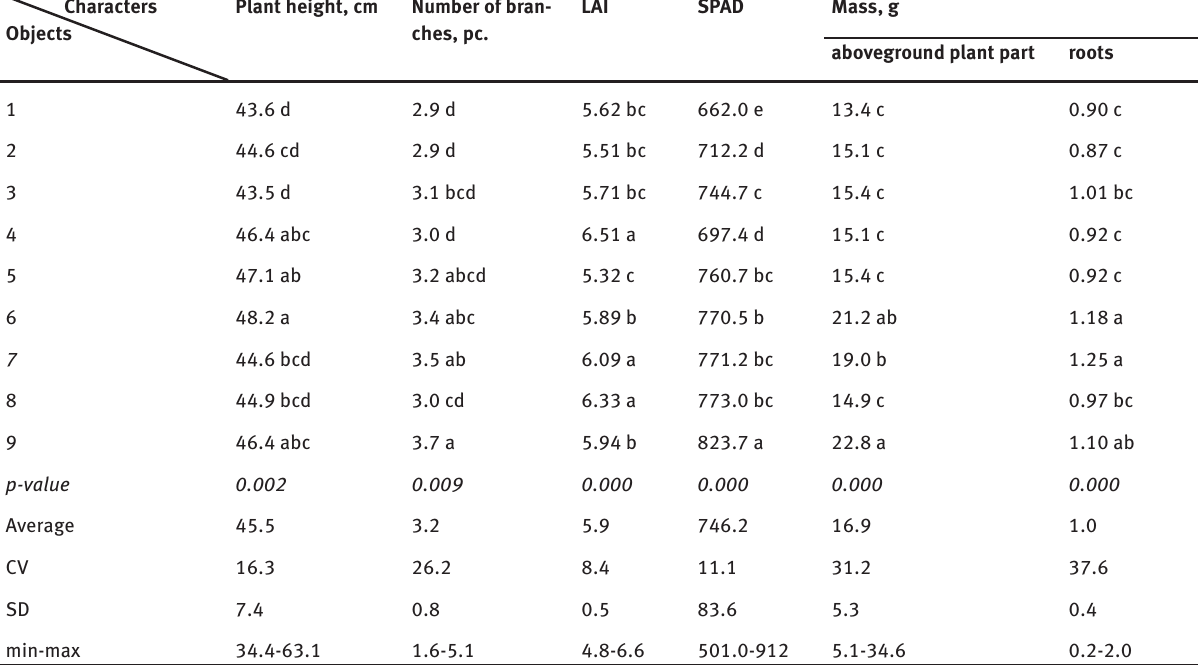
Table 2: Influence of vaccination treatment in white lupine seeds on height, number of branches, leaf area index, chlorophyll content index and mass of aboveground plant part and